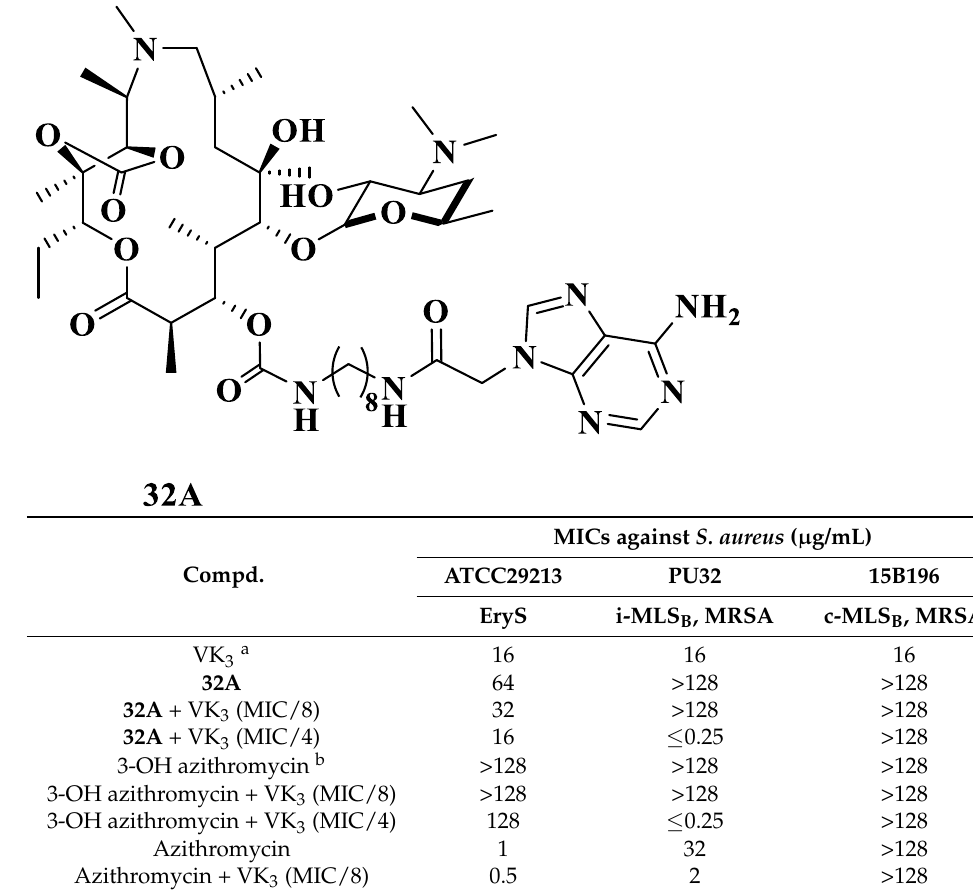
Table 3. In vitro antibacterial activity of 32A alone or in combination with menadione against S. aureus .